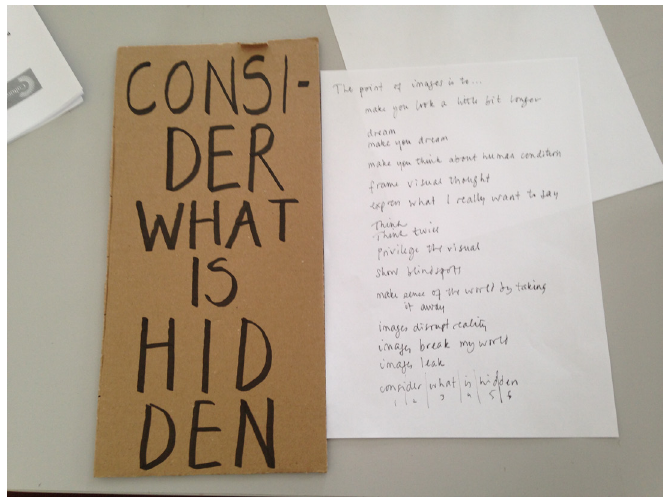
Figure 4. First and second stages side by side The second stage, after the participants had written a set of statements, was to choose the base material on which to write (paper, cardboard, plastic, tape), its size and colour, the writing implements (pens, pencils, markers, crayons, colours), and, finally, designing the shape, colour and size of the words. Here the responses were diverse, some choosing cardboard (see Figures 3 and 4) and some preferring digital means (see Figure 5). The next step was to select the background of the image and the placement of the body, the placard, the red item and the camera. The red item, a constant in the “Wozu Poesie?” images, had various functions: it concealed the identity of the poet when this was necessary due to the political situation in the country where the image was taken; it unified the images, making all of them belong, a constant among all participants; and it focused the gaze, with its vivid colour. To that, it can also be added, of course, political associations of red with the left and revolution. Lastly, the photograph was taken.